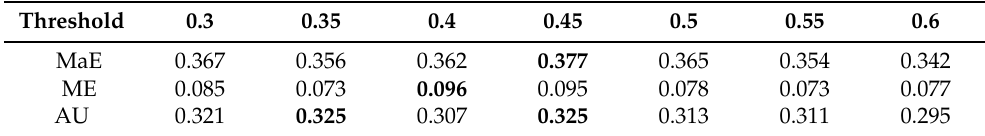
Bold font indicates the best